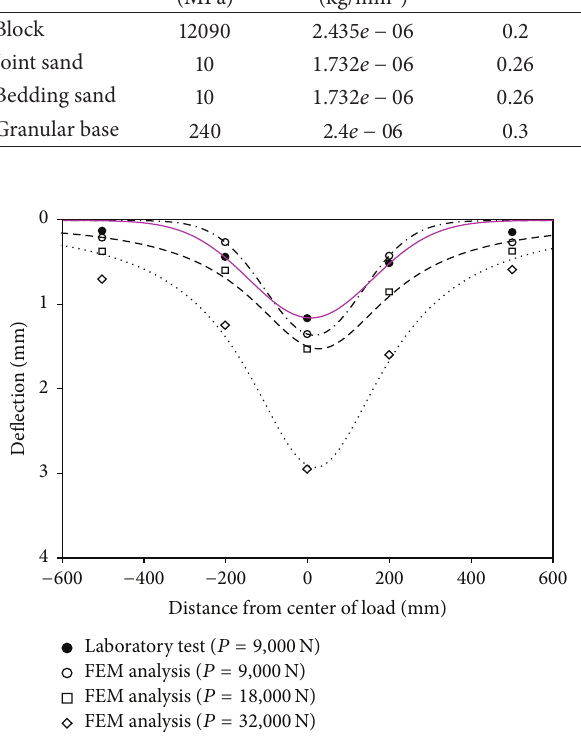
Figure 4: Comparison of deflection from the analysis and test